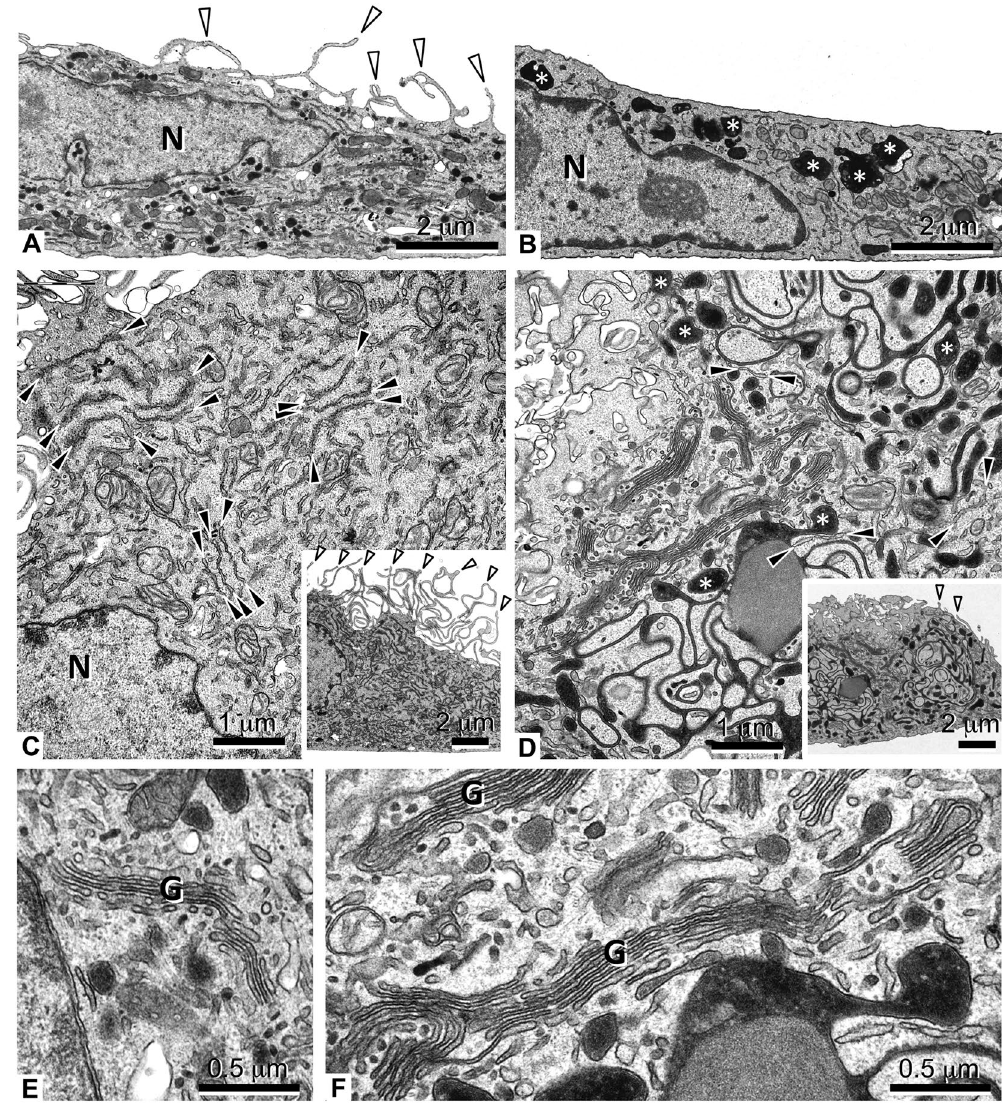
Figure 7. Transmission electron microscopy of osteoclasts. Monocytes were plated in plastic cell culture dishes. Differentiation to osteoclasts and oxLDL treatment was performed as described. Control ( A , C , E ) and oxLDL treated ( B , D , F ) treated cells are shown. ( A , B ) Overviews showing the apical (top) and basal (bottom) side of the cells. Note the apical cell extensions (white arrowheads) in the control, which are mostly absent in the oxLDL treated. Electron dense, membrane surrounded compartments ( B , asterisks) were predominantly observed in oxLDL treated osteoclasts. Higher magnifications of the cytoplasm ( C , D ; insets: overviews of the cells, white arrowheads: apical cell extensions) reveal rough endoplasmic reticulum (ER) in both samples ( C , D ; black arrowheads). In the oxLDL treated cells, electron dense compartments ( D , asterisks) also appear as cisternae, in that case only few ER cisternae are observed. Golgi stacks appear enlarged in oxLDL treated osteoclasts ( E , F ). N, nucleus; ( G ) Golgi. Scale bars are 2 µ m in ( A , B ) 1 µ m in ( C , D ) 2 µ m in the insets of ( C , D ) 0.5 µ m in ( E , F ) n =